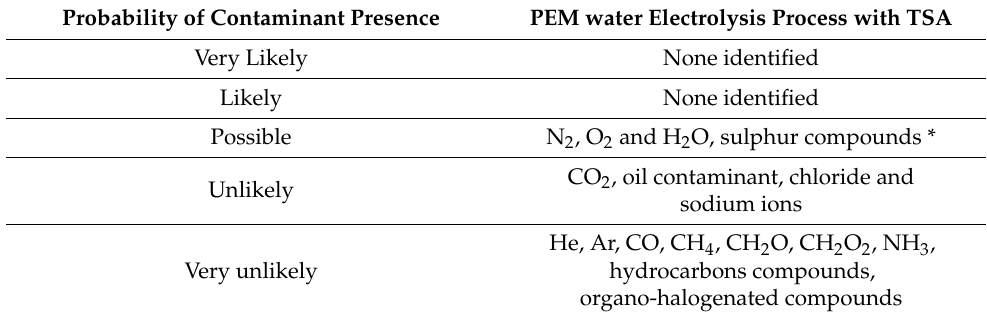
Table 7. Summary of contaminant presence in the PEMWE using purified seawater onboard Energy